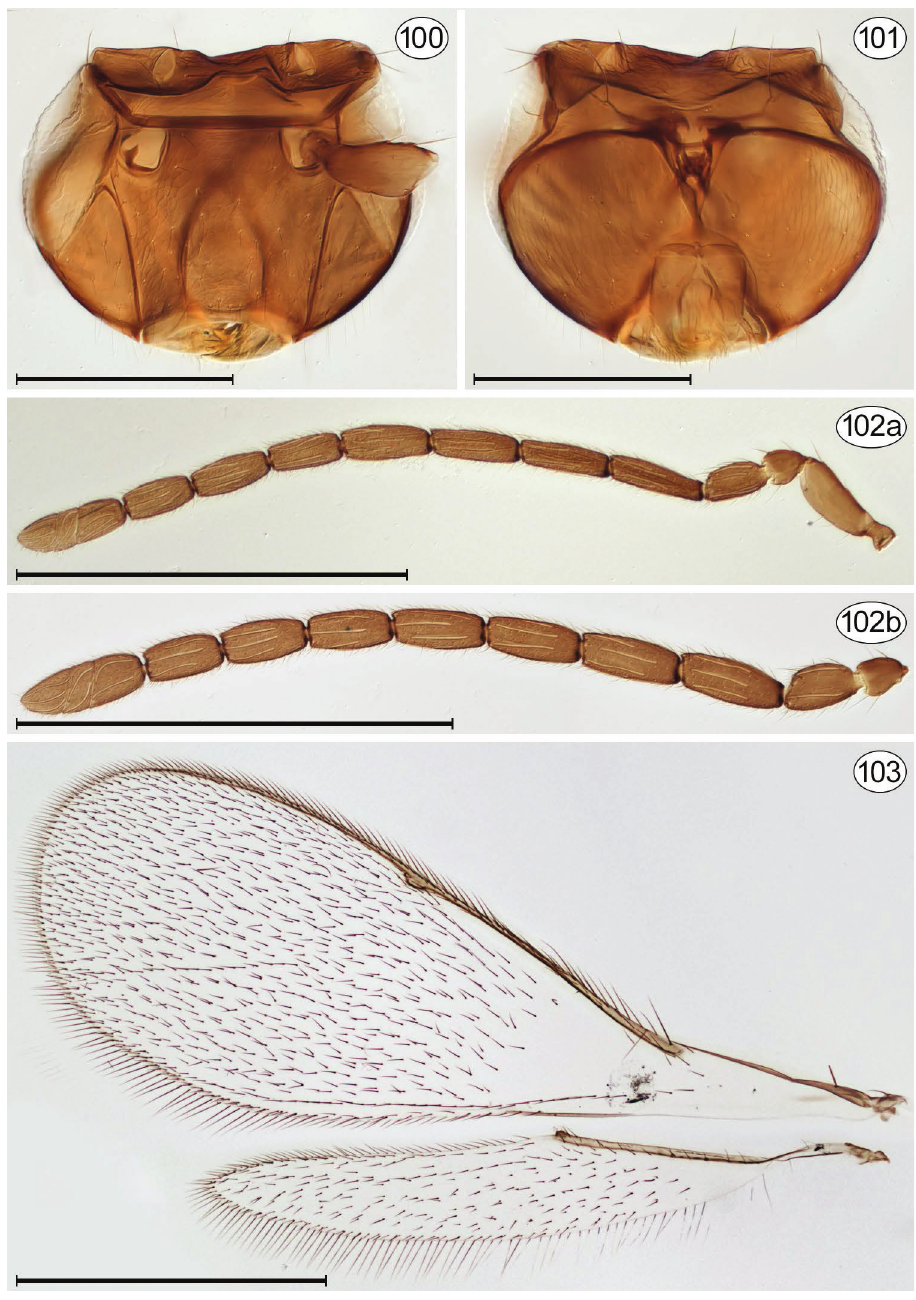
Figures 100–103. Neotriadomerus gloriosus , holotype. 100 head, anterior 101 head, posterior 102a right antenna 102b left antenna 103 wings. Scale bar for 100, 101 = 200 μm; 102, 103 = 500